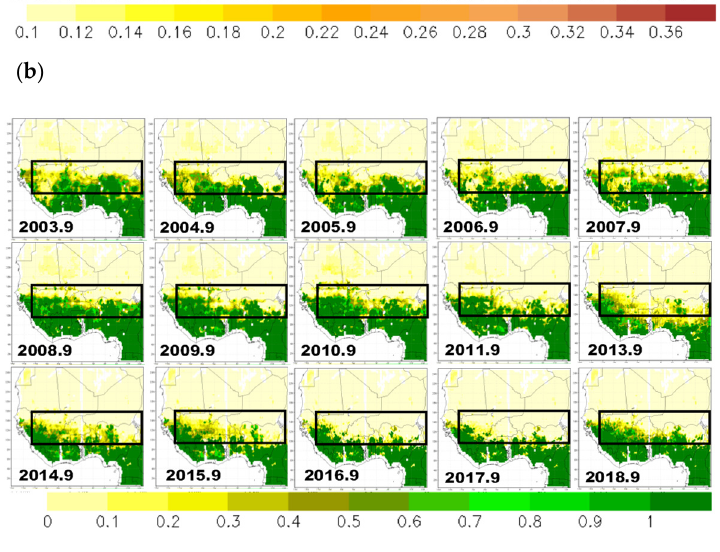
Figure 3. Spatial distribution of ( a ) near-surface soil moisture content (m 3 /m 3 ), ( b ) root-zone soil moisture content (m 3 /m 3 ), and ( c ) vegetation water content (m 3 /m 3 ) from CLVDAS (September monthly averages in the period 2003–2018; spatial resolution is 0.25° × 0.25°). Black rectangle outlines the Sahel-inland region. In the Sahel-inland region, vegetation water content has shown a trend of decrease from the north since 2011 ( c ). This trend has also shown in the root-zone soil moisture content ( b ) although not clearly in the near-surface soil moisture content ( a ).